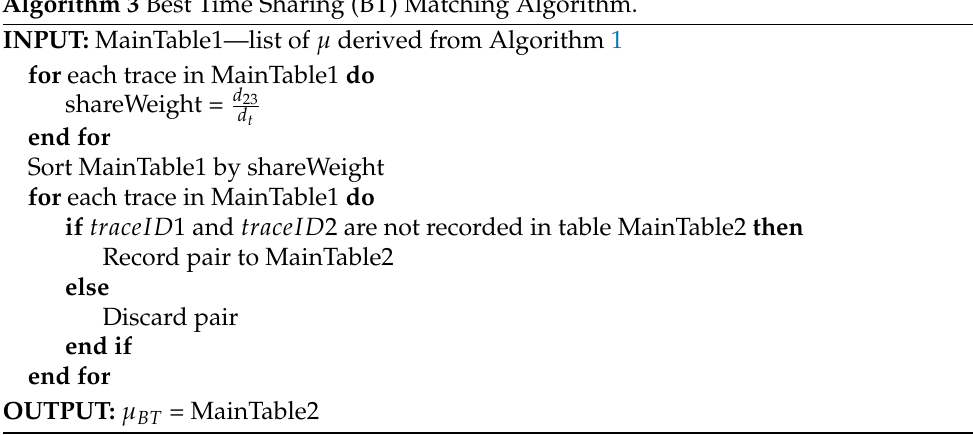
Algorithm 3 Best Time Sharing (BT) Matching